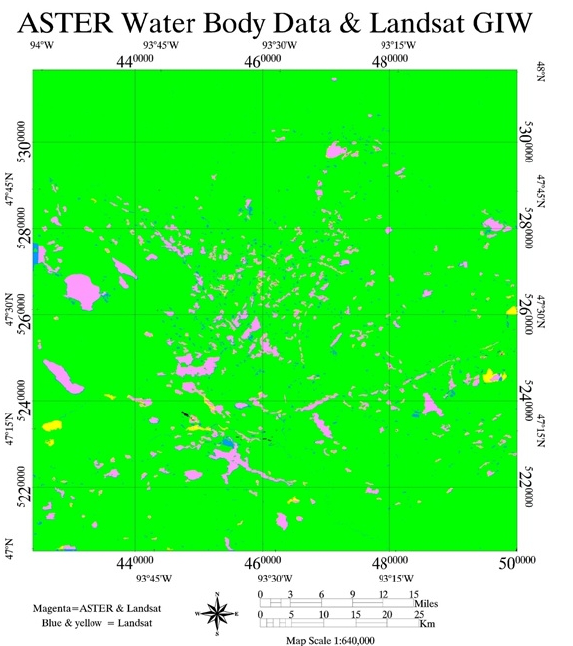
Figure 3. Patagonia tile divided in half: GIW (left) and AWBD (right). See text for